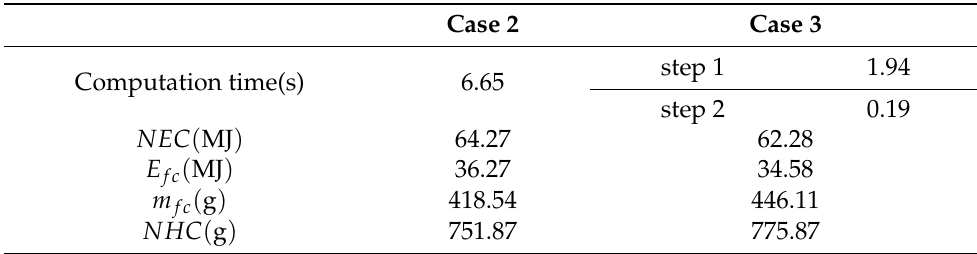
Table 5. The performance comparison between co-optimization and sequential optimization without speed limit and gradient.